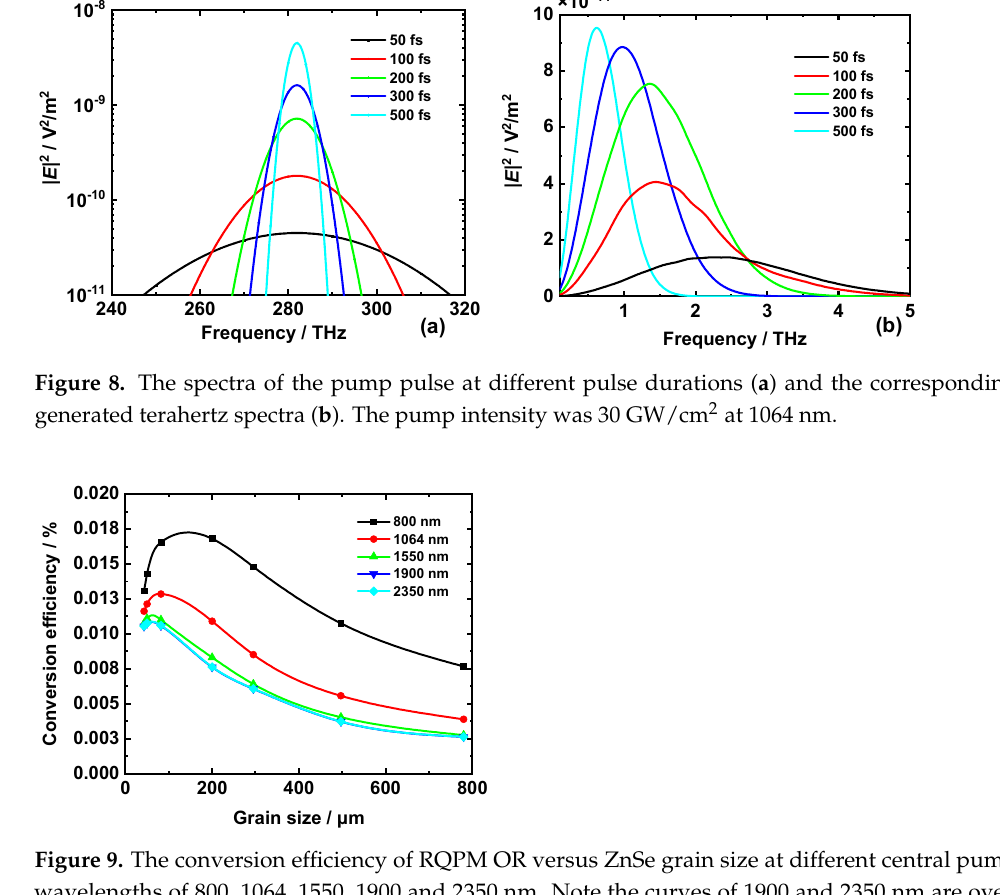
Figure 9. The conversion efficiency of RQPM OR versus ZnSe grain size at different central pump wavelengths of 800, 1064, 1550, 1900 and 2350 nm. Note the curves of 1900 and 2350 nm are over- lapped.